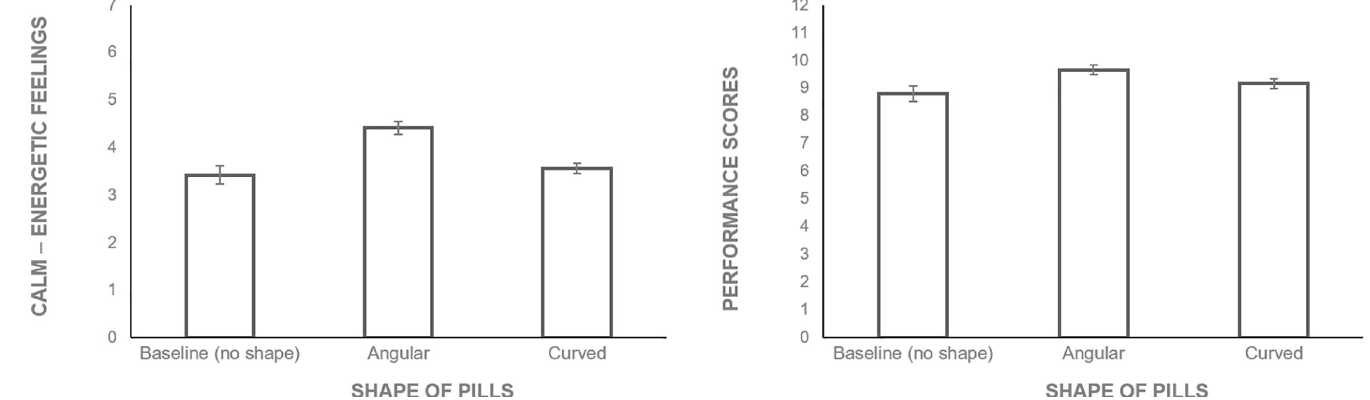
Fig 7. Shape-evoked differences in subjective and performance scores in Study 2. The bars represent SE.